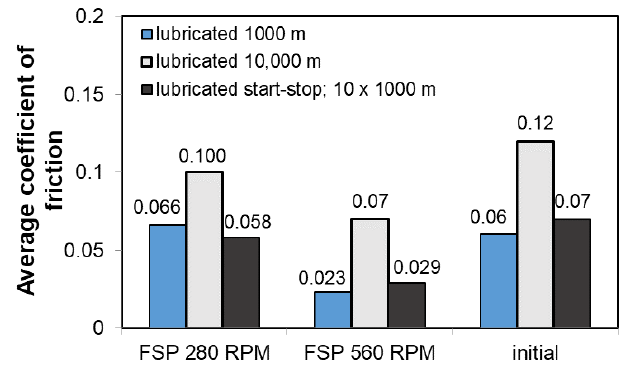
Figure 11. Coefficient of friction determined at load of 50 N.